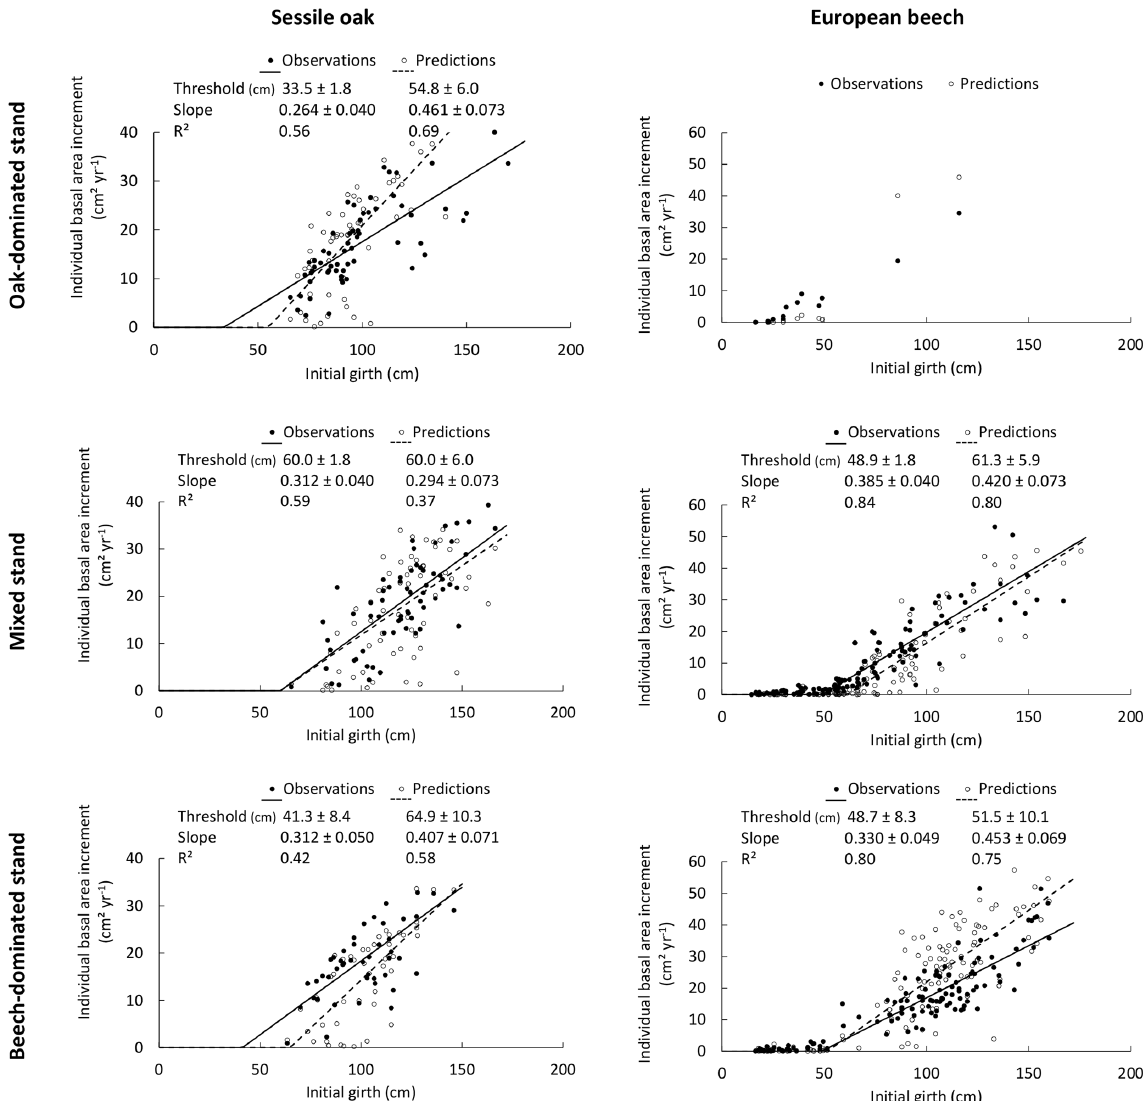
Figure 4. Reconstruction of the size–growth relationships for sessile oak and European beech in the three stands using the photosynthesis method of CASTANEA, the npp to gpp ratio approach to account for tree respiration and the distance-dependent crown extension. The predicted relationships between the individual BAI (calculated for the 2001–2011 period) and the initial girth are compared with observed ones. The solid and dashed lines represent the segmented regression applied, respectively, to observations and predictions to determine the girth threshold beyond which radial growth linearly increases with girth and to estimate the slope of the linear relationship between BAI and initial girth. The 95% confidence intervals for the intercept and the slope are provided as well as the R 2 of the model. No relationship was fitted for the European beech in the oak-dominated stand given the lack of